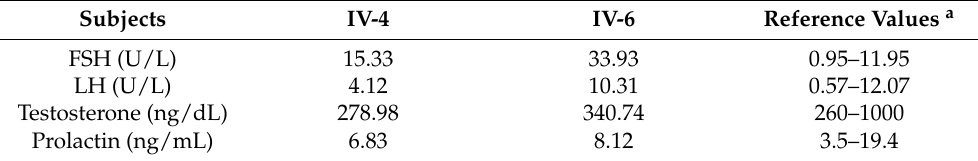
Table 2. The hormone